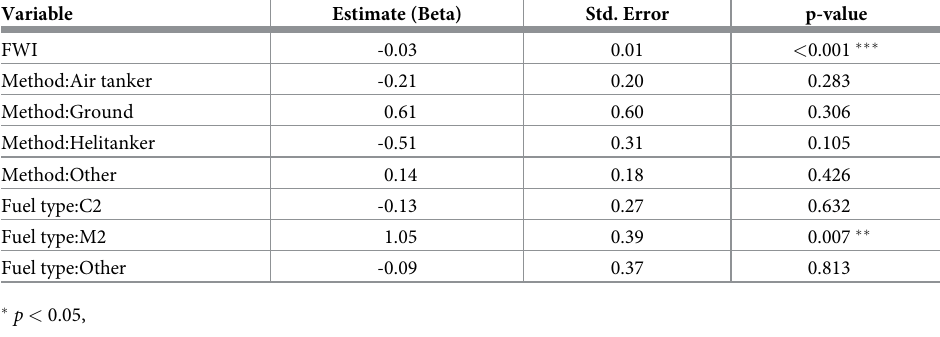
Table 6. Parameter estimates, standard errors (Std. Error) and p-values from the fitted Cox proportional hazards model. Variable Estimate (Beta) Std. Error p-value FWI -0.03 0.01